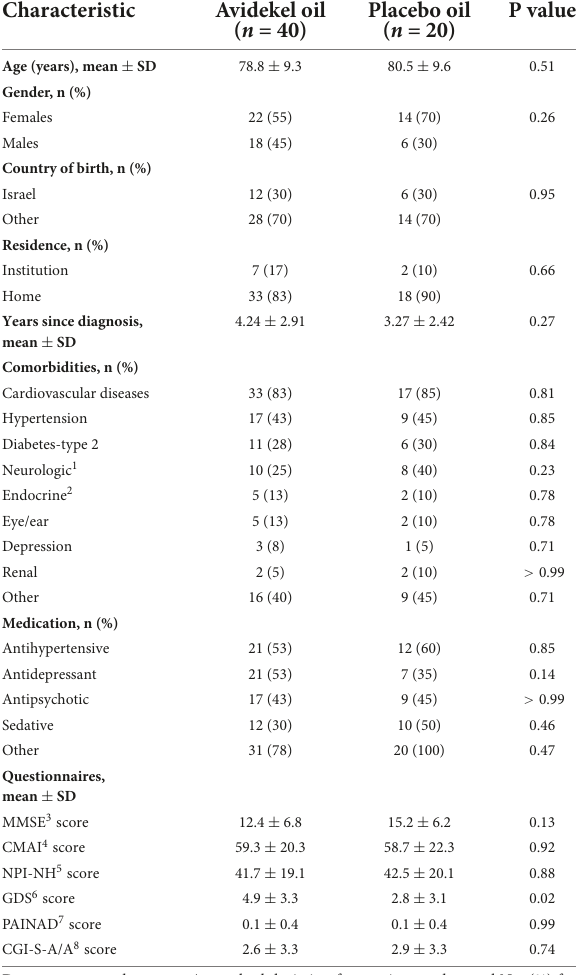
TABLE 1 Characteristics of the patient population at